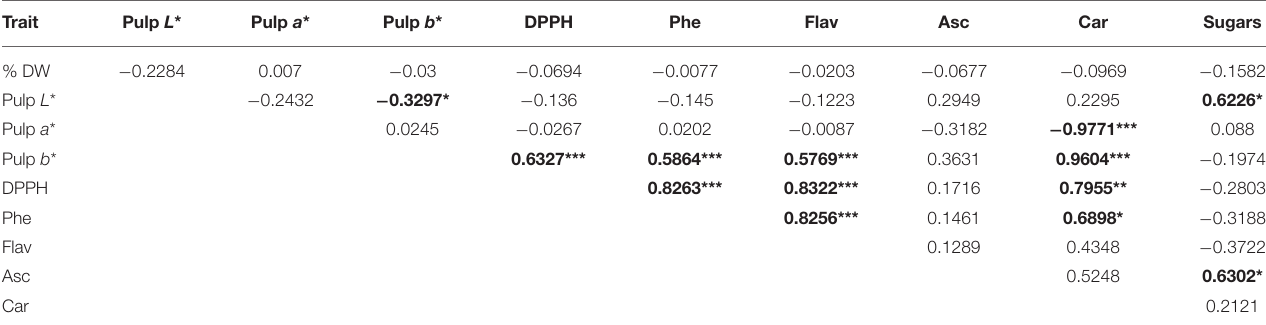
TABLE 7 | Linear correlation coefficient (r) and its significance between fruit quality traits (dry weight, pulp colour, nutraceutical compounds, and sugars) in the collection of the three eggplant landraces (B14, B16, B17) cultivated in Spain.